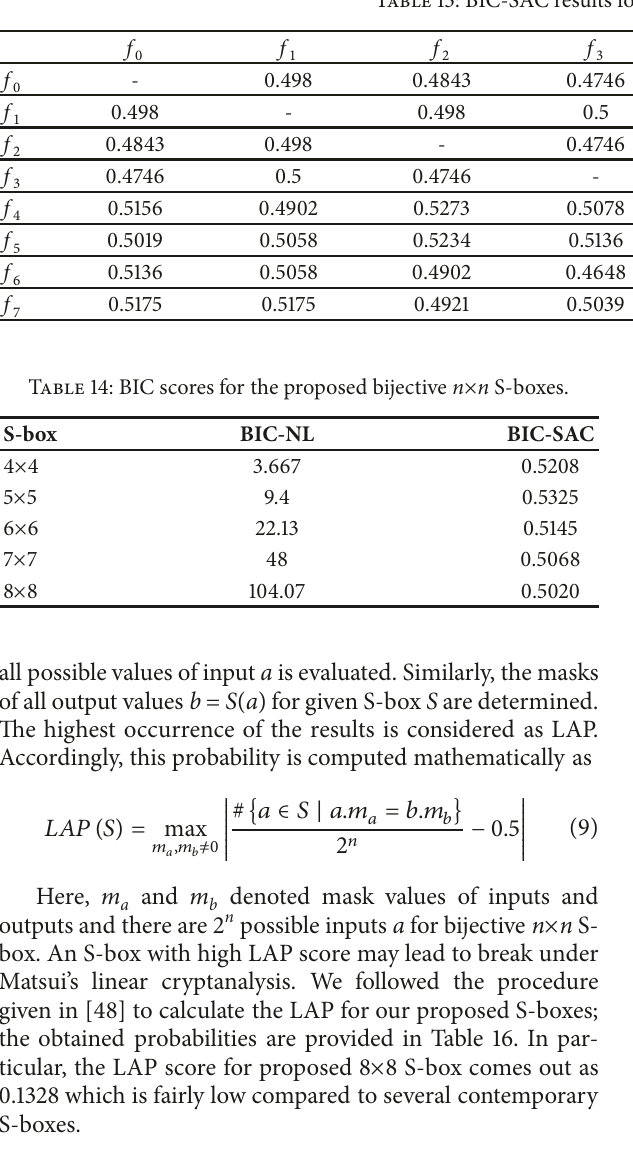
Table 13: BIC-SAC results for the proposed 8 × 8 S-box.